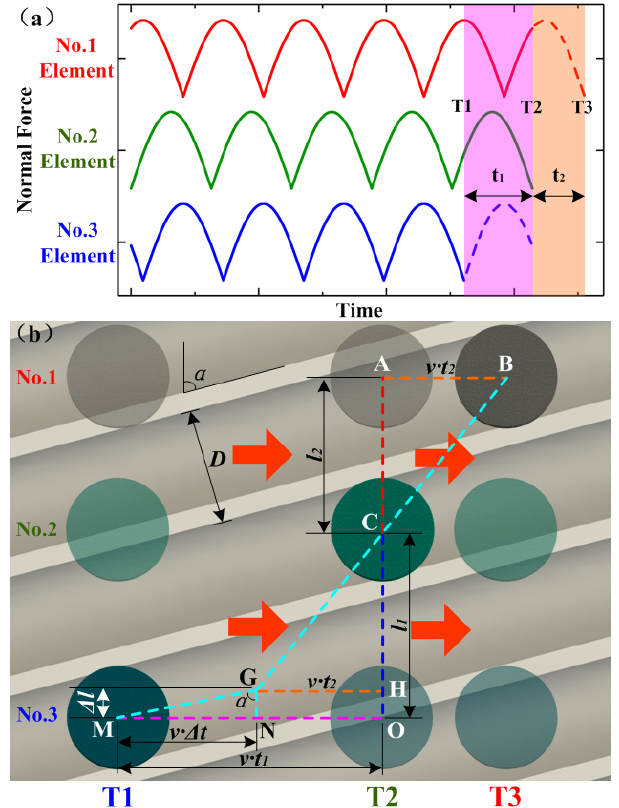
Figure 7. ( a ) Force-time curves of No. 1–3 units, ( b ) schematic view for the calculation of inclined angle α.